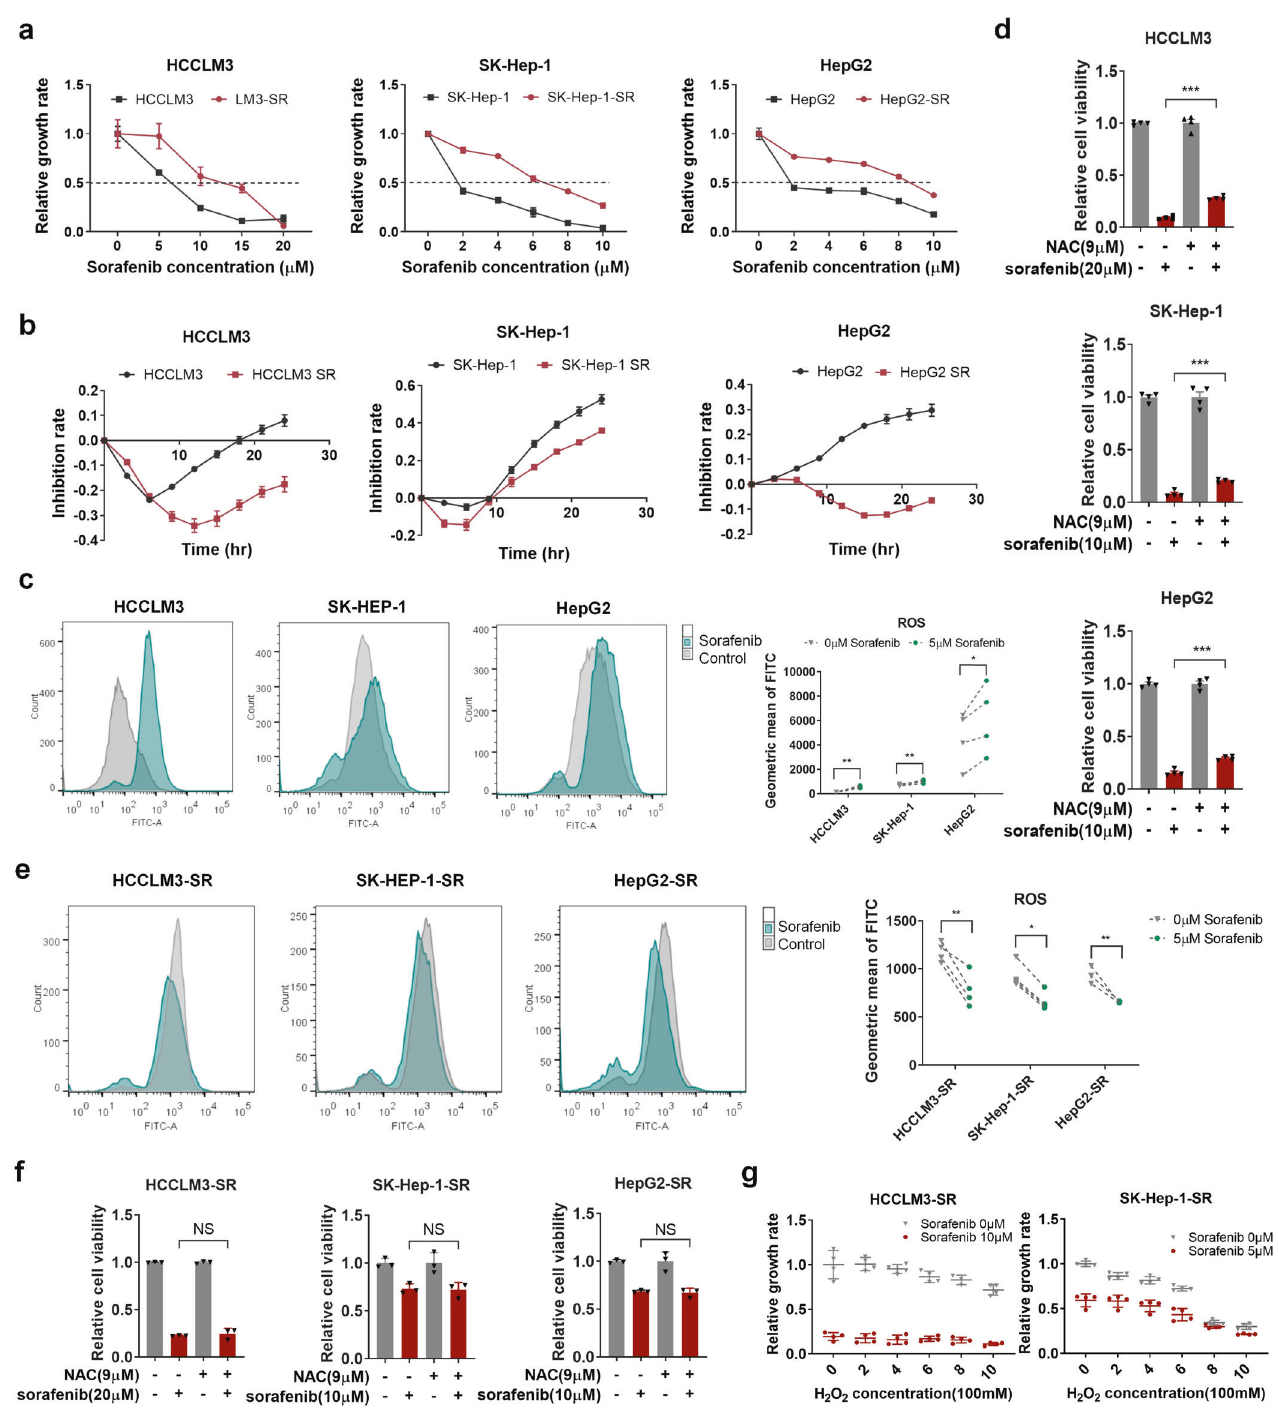
revealed the inhibition rates of sorafenib (HCCLM3: 10 µM, SK-Hep-1: 5 µM, HepG2: 5 µM) over time. c , e Intracellular ROS levels were measured using a DCFH-DA probe via fl ow cytometry with or without 48 h of sorafenib treatment (5 µM) in parental and resistant cells. d , f Cell viability was measured by CCK-8 assay with or without sorafenib treatment and ROS scavenger N -acetyl-cysteine (NAC), which was added to the media 3 h before sorafenib treatment. g Cell viability was measured by CCK-8 assay with or without sorafenib treatment and hydrogen peroxide (H 2 O 2 ). * p < 0.05, ** p < 0.01, and *** p < 0.001. NS not statistically signi fi